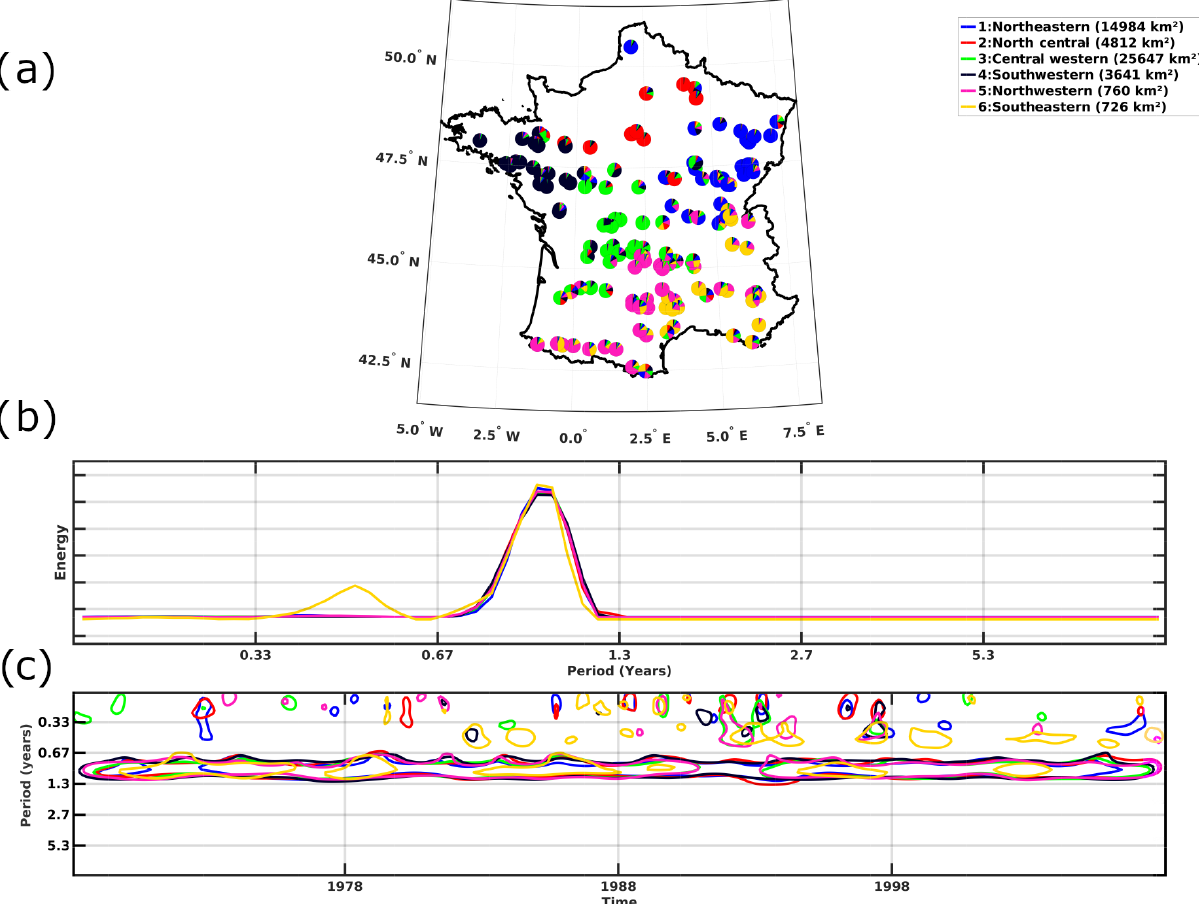
Figure 10. Clustering of discharge time frequency variability in France. (a) Classification map of the watersheds. Pie chart slices show the three highest probability memberships. (b) Global wavelet spectra of homogeneous regions. (c) Wavelet spectra of homogeneous regions. For clarity, only timescales and time locations that are 95% statistically significant and with the largest variability are shown (colored